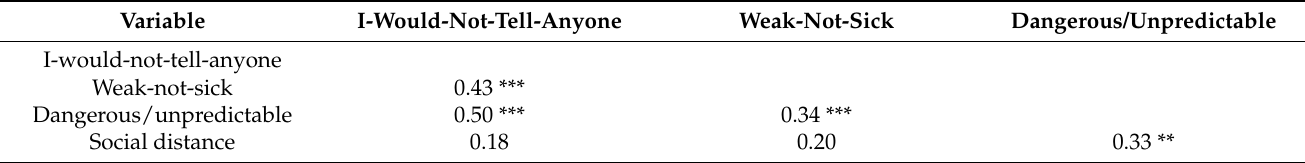
Table 2. Kendall’s Tau-b Correlations of Personal Stigma Subscales and Social Distance